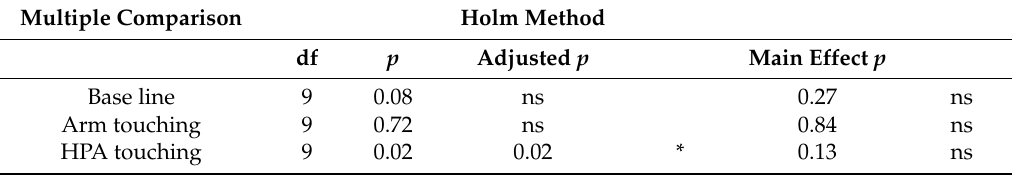
Table 10. The result of the multiple comparison of RSA of the trauma